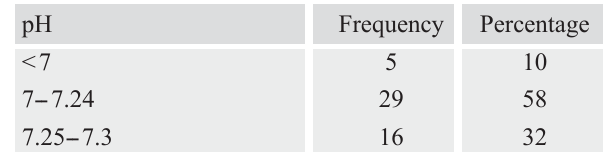
Table II: Severity of DKA (N=50)